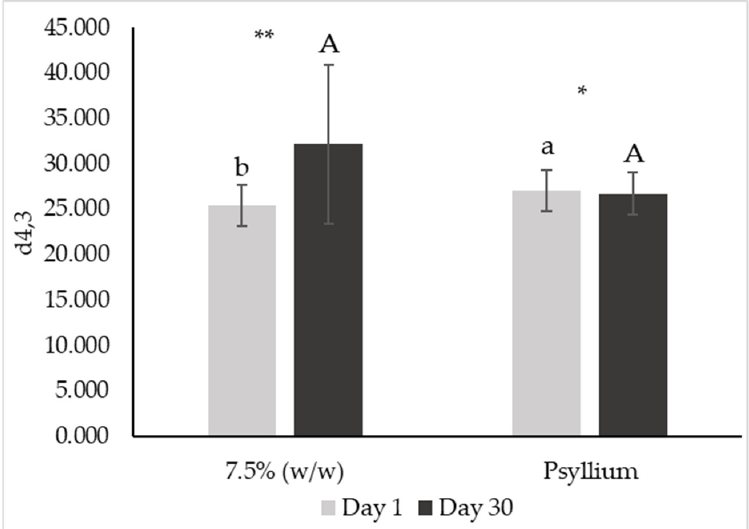
Figure 14. De Brouckere diameter (d 4,3 ) from droplet size distribution of emulsions with 7.5% ( w / w ) of miso paste, one of them with 0.1% ( w / w ) of psyllium husk, measured 1 (a) and 30 (b) days after emulsion preparation. Different letters or two asterisks indicate significantly different results ( p < 0.05) according to t -test. One asterisk indicates that samples did not present significantly different results ( p > 0.05) according to t -test.